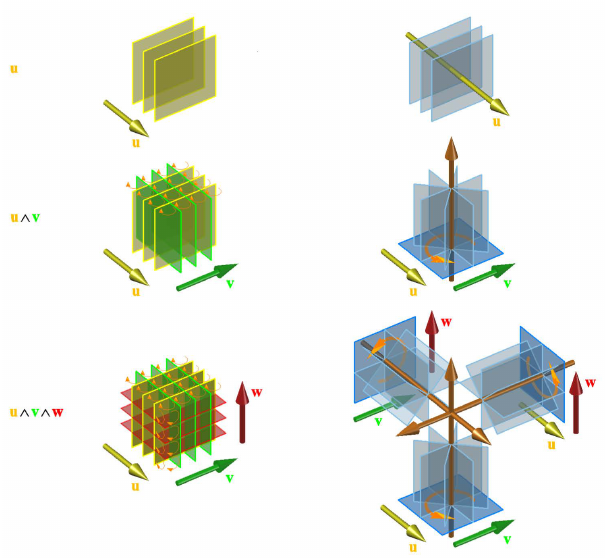
Figure 20: Geometric interpretation of the attitude of a p -vector in terms of class